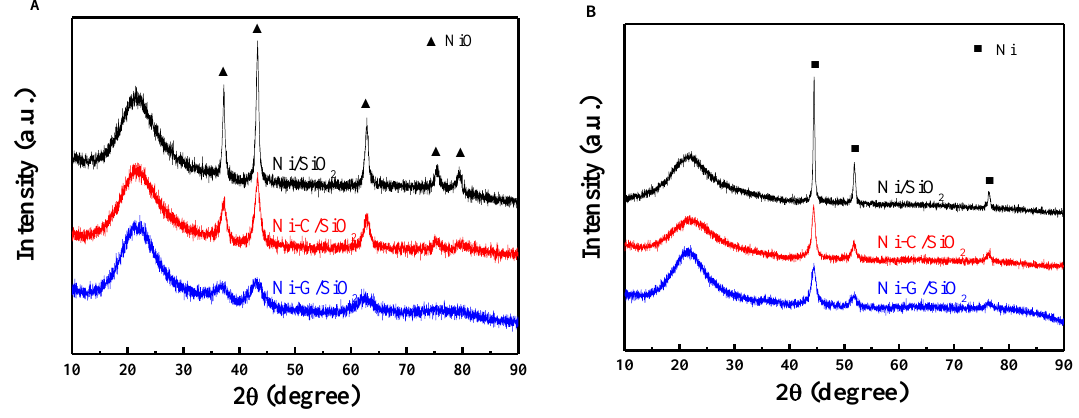
Figure 1. XRD pattern for the calcined ( A ) and reduced ( B ) catalysts. Table 1. Summary of the textural and crystal properties of different samples.